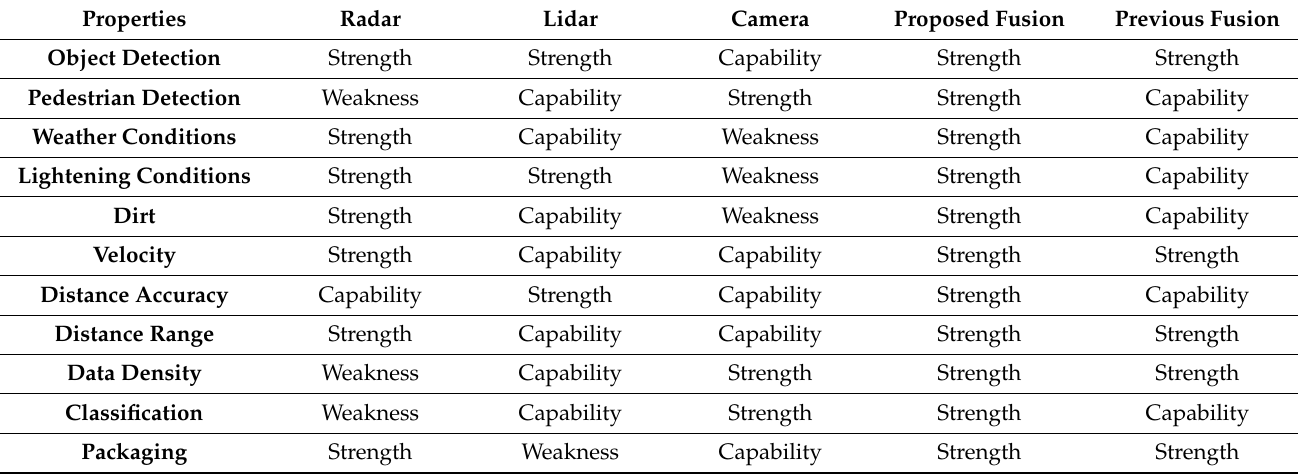
Table 2. Detail properties of radar, vision, lidar, proposed fusion, and previous